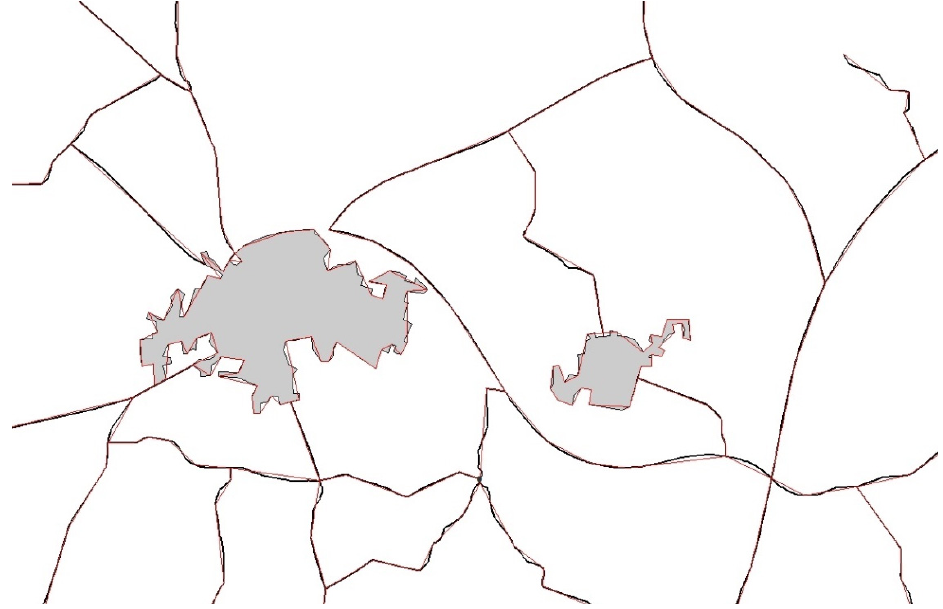
Figure 12. Section of the area enlarged to highlight the differences between before and after gener- alization.